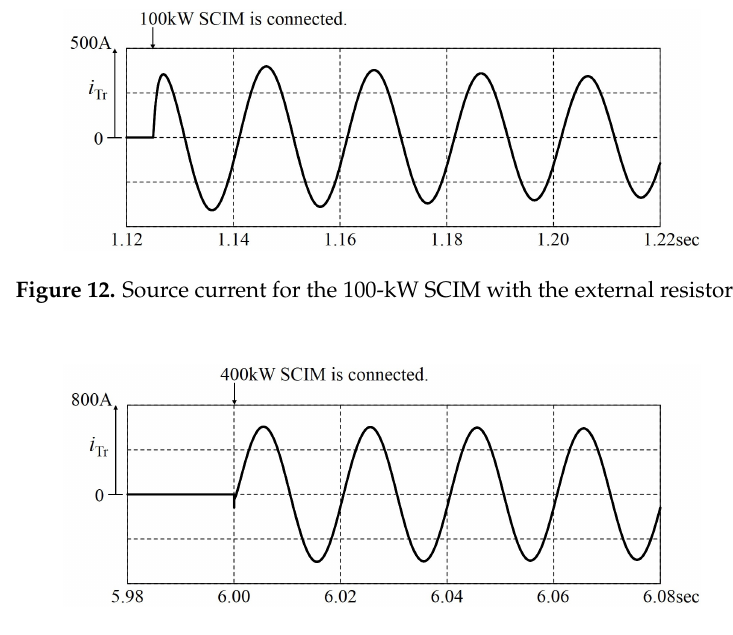
Figure 13. Source current for the 400-kW SCIM with the external